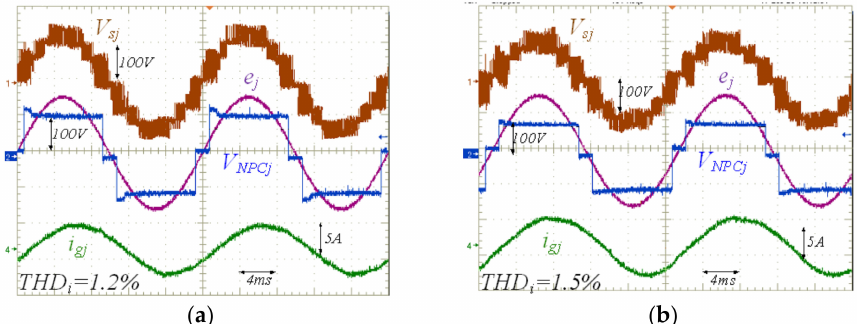
Figure 14. The (3LI + TLI) steady state. ( a ) Balanced voltage, V DC (cid:48) = 200 V, V c 1 = 100 V, V c 2 = 100 V, V DC (cid:48)(cid:48) = V DC (cid:48) /2 = 100 V. ( b ) Unbalanced voltage, V DC (cid:48) = 170 V, V c 1 = 70 V, V c 2 = 100 V, V DC (cid:48)(cid:48) = 100 V. Secondary phase voltage V sj , grid phase voltage e j , grid phase current i gj , and NPC output voltage